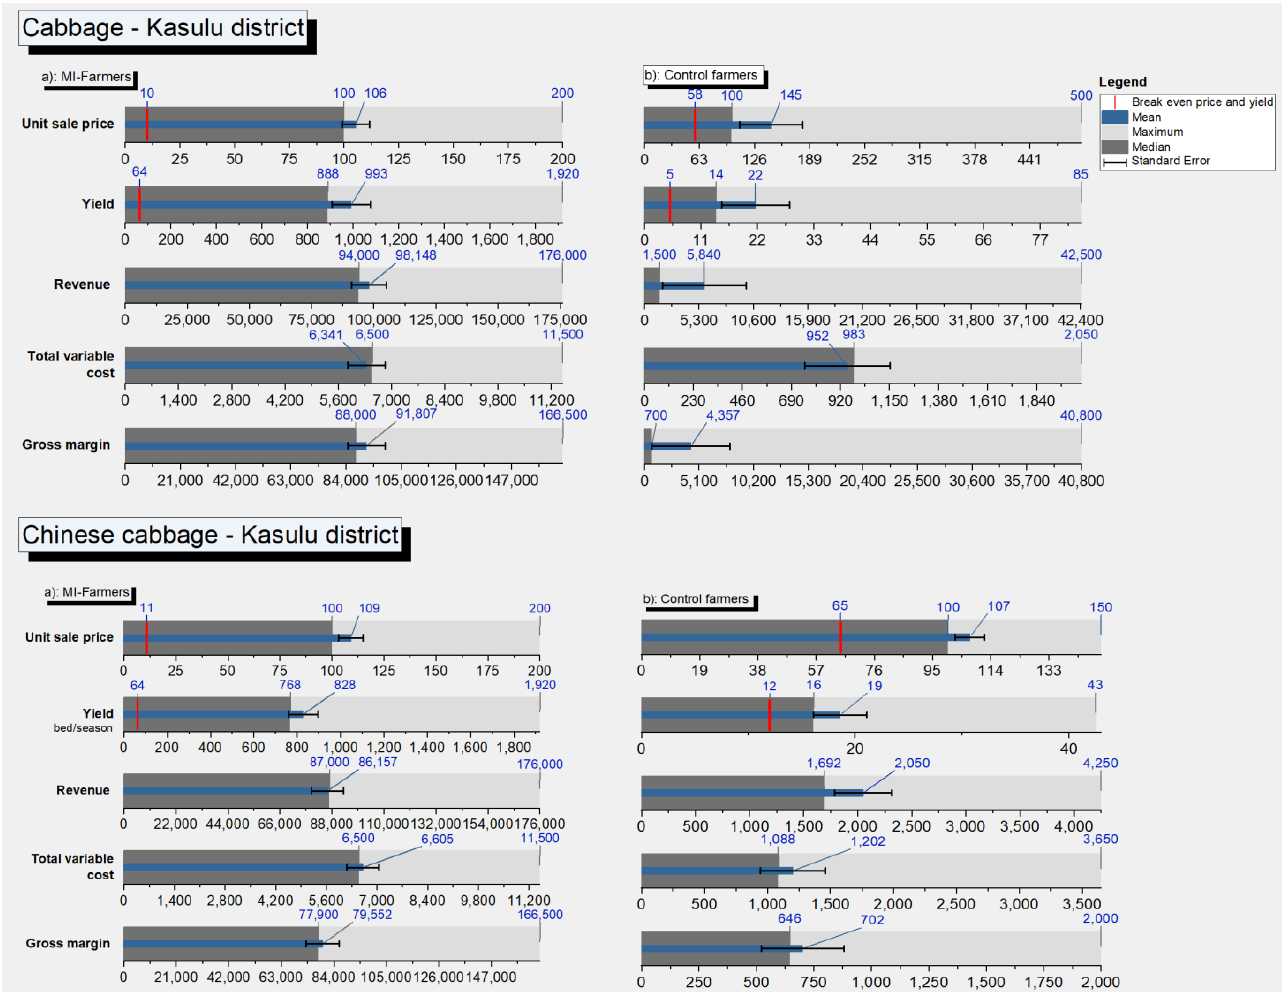
Figure 5. Enterprise comparison of MI farmers ( a ) and control farmers ( b ) growing cabbage and Chinese cabbage in the Kasulu district. Price, revenue, total variable cost (TVC), and gross margin (GM) amounts are presented in Tanzanian Shilling (TSh), where 1 USD = 2330 TSh and 1 TSh = 0.00043 USD. Yield is calculated as per bed per season. Standard error of mean is presented as error bars for each bar graph.